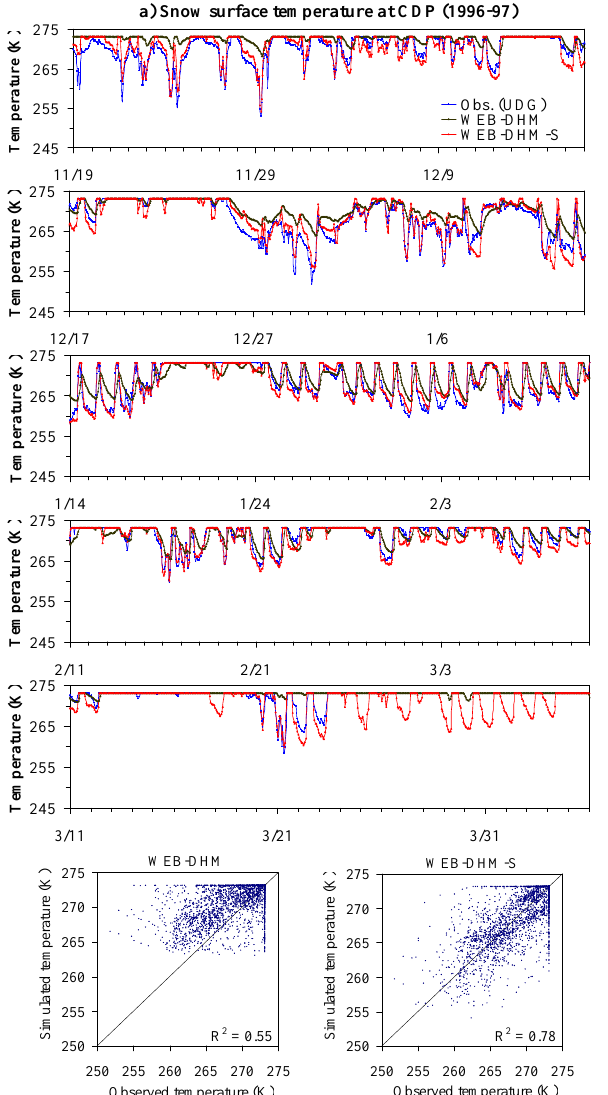
Fig. 4b. Same as in Fig. 4a at CDP (1997–1998) from 3 Decem- ber 1997 to 5 May